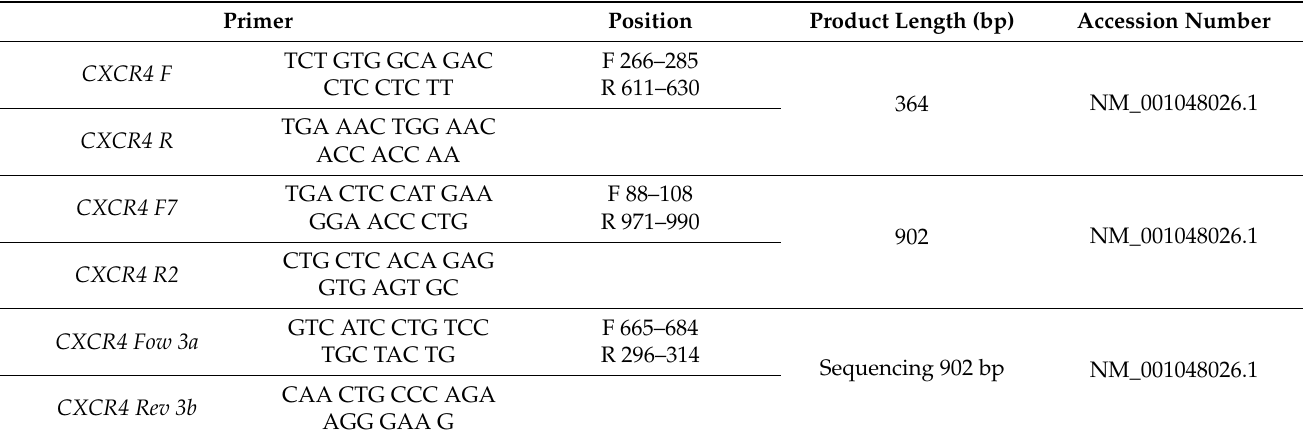
Table 3. Primers for the amplification and sequencing of